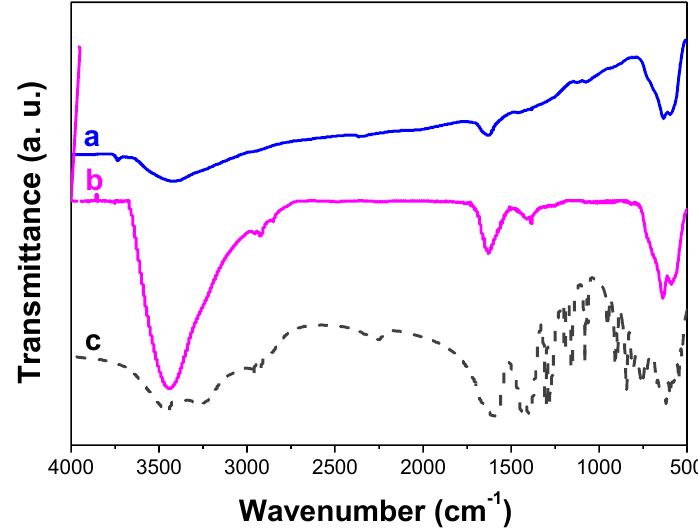
Figure 4. Fourier transformed infrared (FTIR) spectra of the ( a ) as-produced β -NaY 0.8 Eu 0.2 F 4 @ γ -Fe 2 O 3 particles and ( b ) their related citrated coated counterparts, compared to ( c ) that of sodium citrate salt. The characteristic symmetric (1390 cm ) and antisymmetric (1590 cm ) stretching bands of the carboxylate C = O groups of the citrate entities were clearly evidenced in the spectrum after citrate functionalization. Also, the symmetric and antisymmetric stretching bands of alkyl C–H groups of the − 1 citrate ions were located at 2880 and 2930 cm , respectively. The FTIR bands ascribed to these organic groups are strong indications of the grafting of citrates on to the particle’s surface. In addition, inorganic features are also clearly evidenced on both the FTIR spectra of pre- and post-functionalized